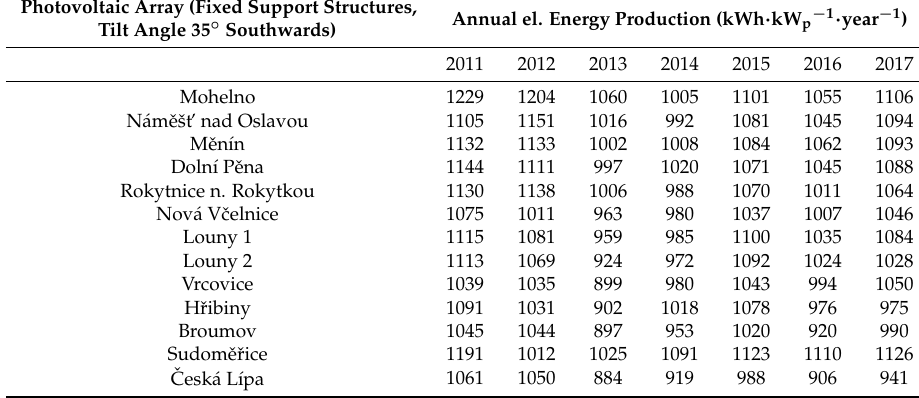
Table 2. Annual electric energy production from selected photovoltaic arrays in the Czech Republic (an example of the evaluation of monitored data).